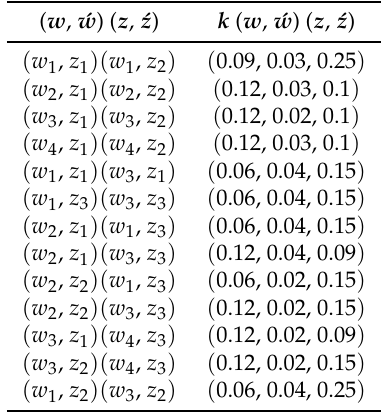
G (cid:3) ( −→ G 1 ) ∗ (cid:3) C ( −→ G 2 ) ∗ ∪